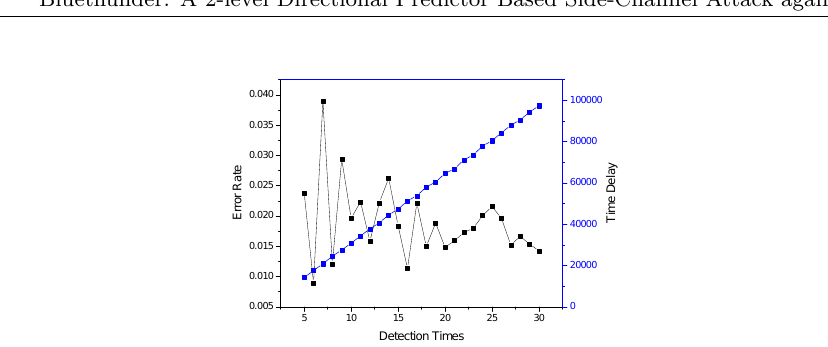
Figure 8: The error rate and time latency of different detection